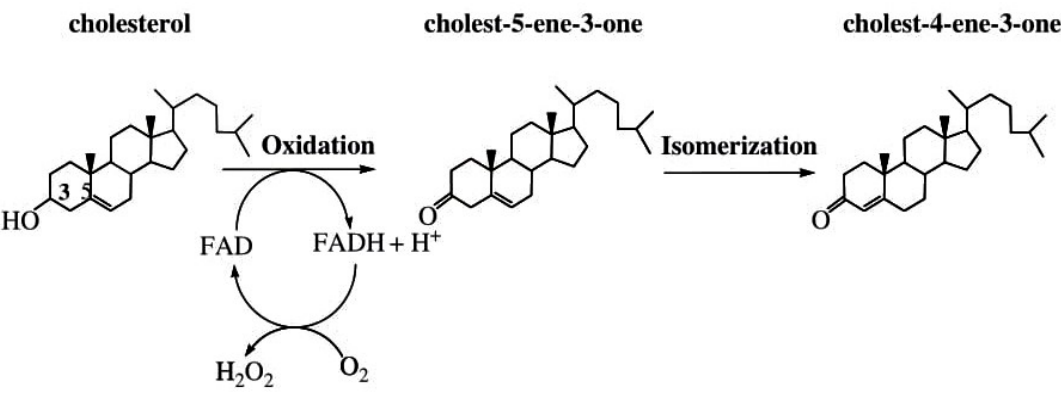
Figure 5. Schematic diagram for the oxidation of β -D-glucose, as catalysed by glucose oxidase (Source: Adányi et al. [85]).